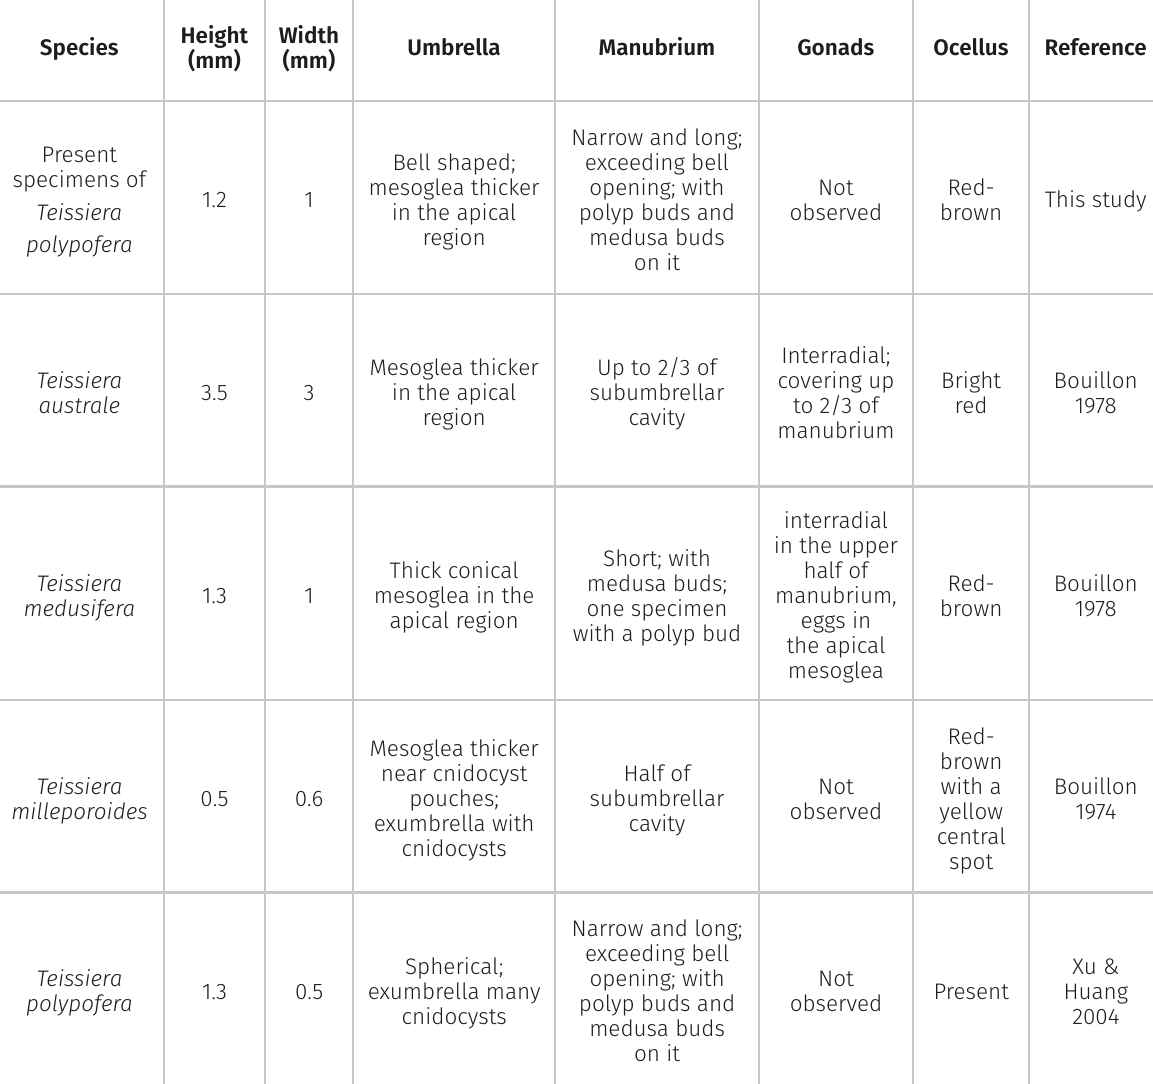
Table II. Comparison of main characters of the valid medusae species of the genus Teissiera. Height Width Species (mm) (mm)